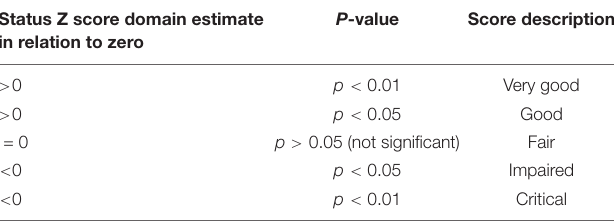
TABLE 7 | Example scoring rubric for Atlantic benthic indicators where the reference value was determined to be in Fair